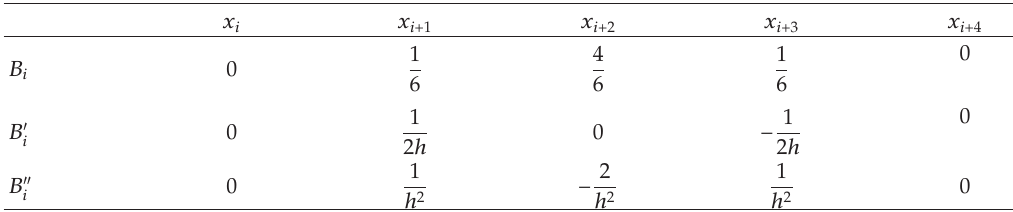
, and B (cid:5)(cid:5) i